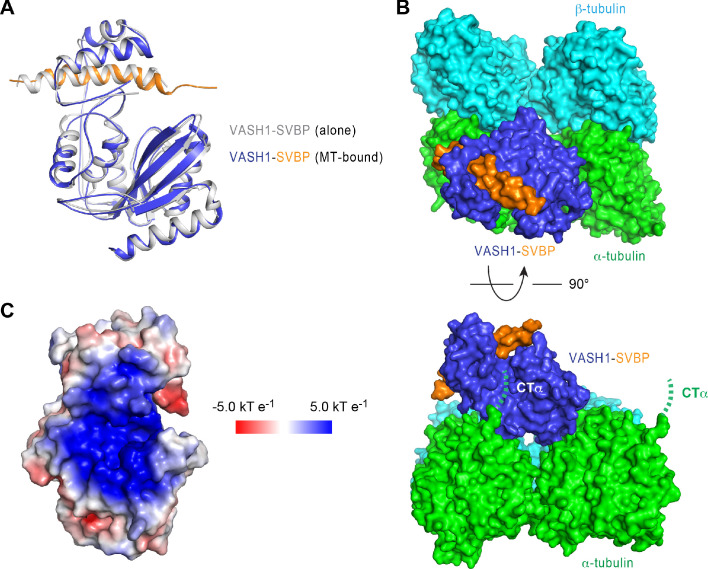
Interactions between microtubules and VASH1-SBVP.(A) Overlay of the ribbon diagrams of the cryo-EM structure of microtubule-bound VASH1-SVBP (colored blue and orange) and the crystal structure of VASH1-SVBP alone (PDB: 6OCG) (colored gray). (B) Surface drawing of the structure of VASH1-SVBP bound to two neighboring αβ-tubulin heterodimers in two different views. The C-terminal tail of α-tubulin (CTα) is indicated by a dashed green line. (C) Solvent-accessible surface of the VASH1-SVBP complex (PDB: 6OCG) colored by electrostatic potential (blue, positive; red, negative).